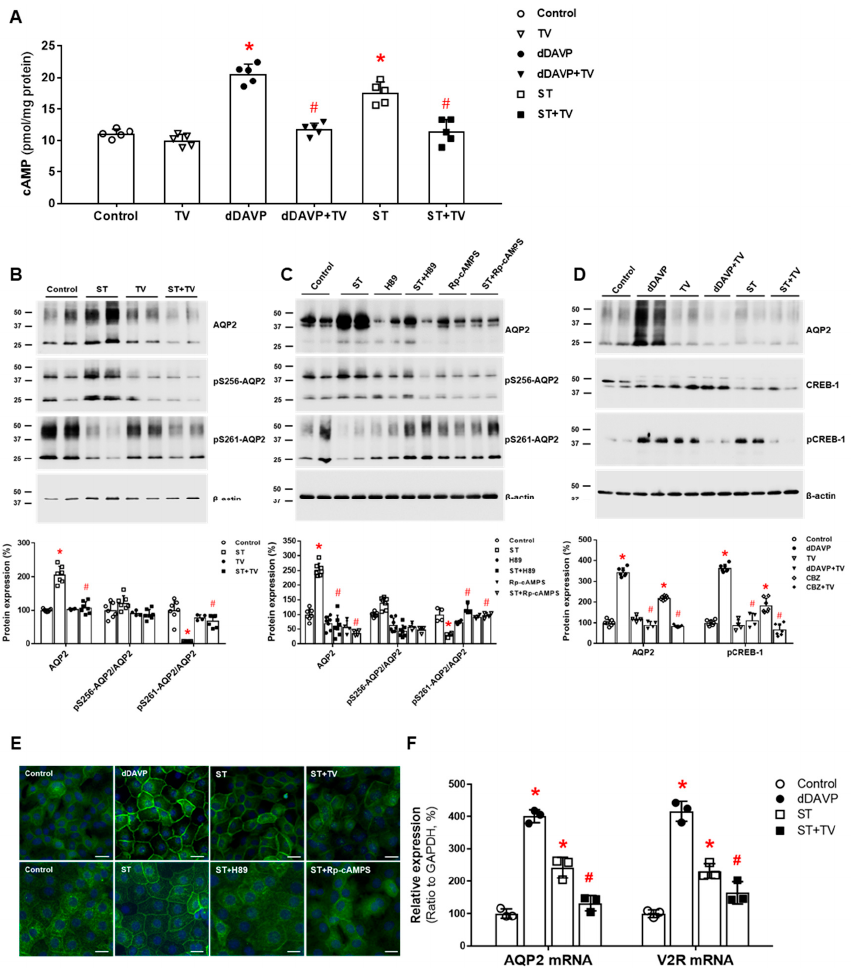
Figure 3. In vitro action of sertraline for aquaporin-2 (AQP2) upregulation in inner medullary collecting duct (IMCD) cells . ( A ) cAMP production was measured by ELISA in IMCD suspensions after treatment with vehicle (control), 100 nM tolvaptan (TV), 10 nM 1-desamino-8-D-arginine vasopressin (dDAVP), and 1 µM sertraline (ST) at 37 °C for 30 min. ( B ) Immunoblot analyses of total AQP2, pSer256-AQP2, and pSer261-AQP2 were performed from primary cultured IMCD cells treated with 1 µM ST with and without 100 nM tolvaptan (TV) for 30 min. ( C ) Immunoblot analyses of total AQP2, pSer256-AQP2, and pSer261-AQP2 were performed from primary cultured IMCD cells treated with 1 µM ST with and without a PKA inhibitor H89 or Rp-cAMPS. ( D ) Immunoblot analyses of total AQP2, total CREB, and pCREB-1 in primary cultured IMCD cells treated with 10 nM dDAVP and 1 µM ST with and without 100 nM tolvaptan (TV). ( E ) Immunofluorescence microscopy for AQP2 in primary cultured IMCD cells shows that AQP2 trafficking was induced by dDAVP and ST but attenuated by coadministration of tolvaptan (TV) or a PKA inhibitor. ( F ) Quantitative polymerase chain reaction data show that AQP2 and vasopressin-2 receptor (V2R) mRNA expression were increased by dDAVP and sertraline (ST) but reversed by tolvaptan (TV) cotreatment. Each bar represents mean ± SD. * p < 0.05 vs. control; # p < 0.05 vs. ST alone by the Mann–Whitney U-test. Adapted from Ref. [38] with permission.